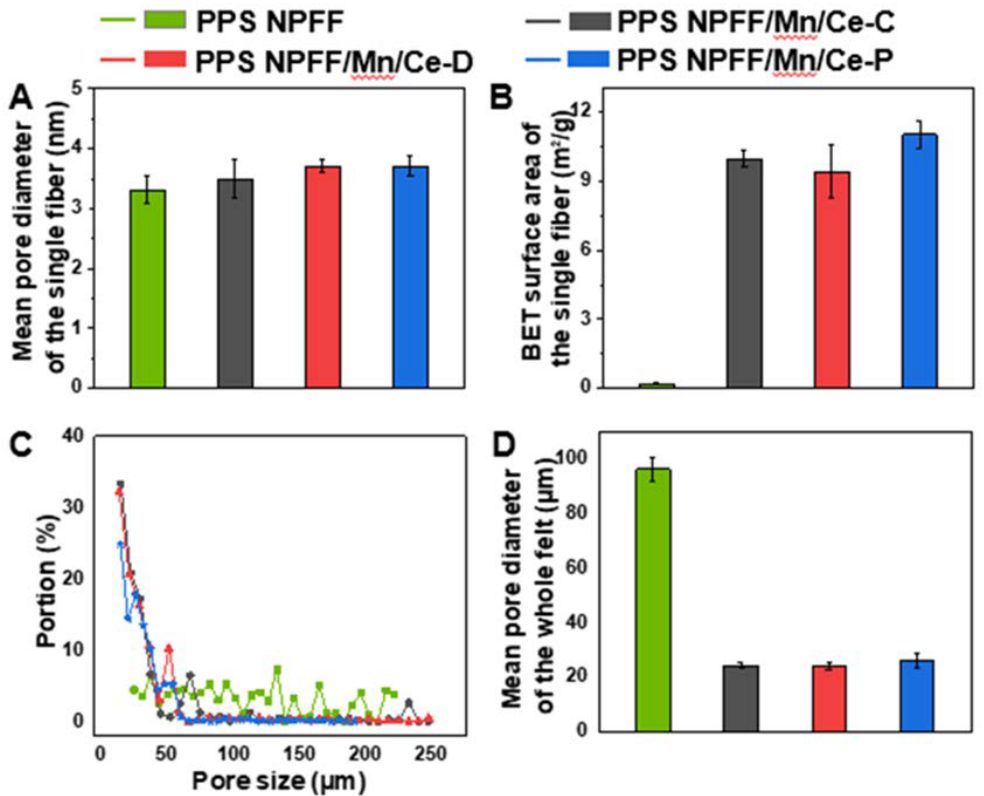
Figure 6. ( A ) Mean pore diameter and ( B ) Brunauer-Emmett-Teller (BET) surface area of the single fiber for the original PPS NPFF and the three different Mn/Ce oxides decorated PPS NPFF; ( C ) pore size distribution and ( D ) mean pore diameter of the whole fibrous felt for the original PPS NPFF and the three different Mn/Ce oxides decorated PPS NPFF.